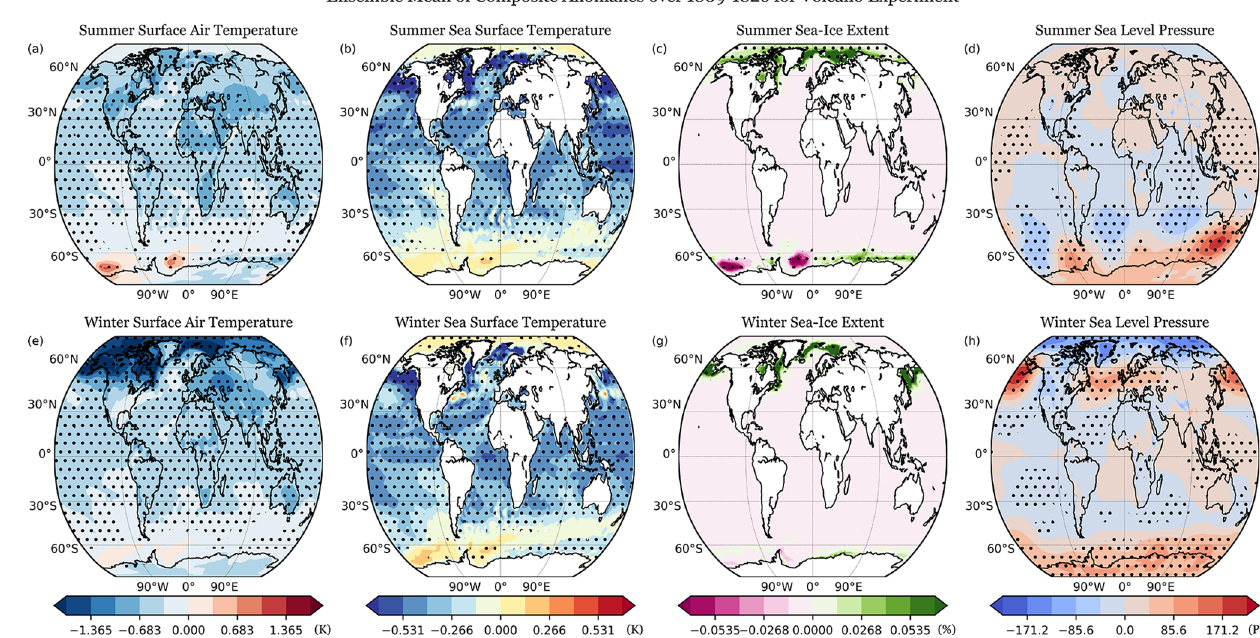
Figure 5. As in Fig. 3 but for the Volcano experiment with two times larger color scales.